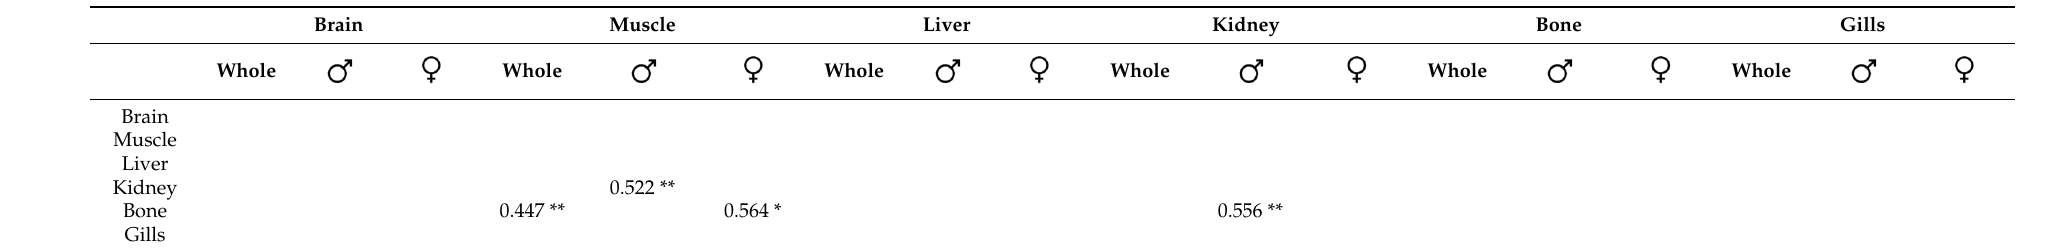
Figure 4. Correlations between tissues for THg concentration in ABFT. The solid line indicates a p-value < 0.01, and a dashed line indicates a p-value < 0.05. The thickness of the line represents the strength of the relationship. Table 4. Statistically significant correlations for Se concentration between tissues of ABFT.